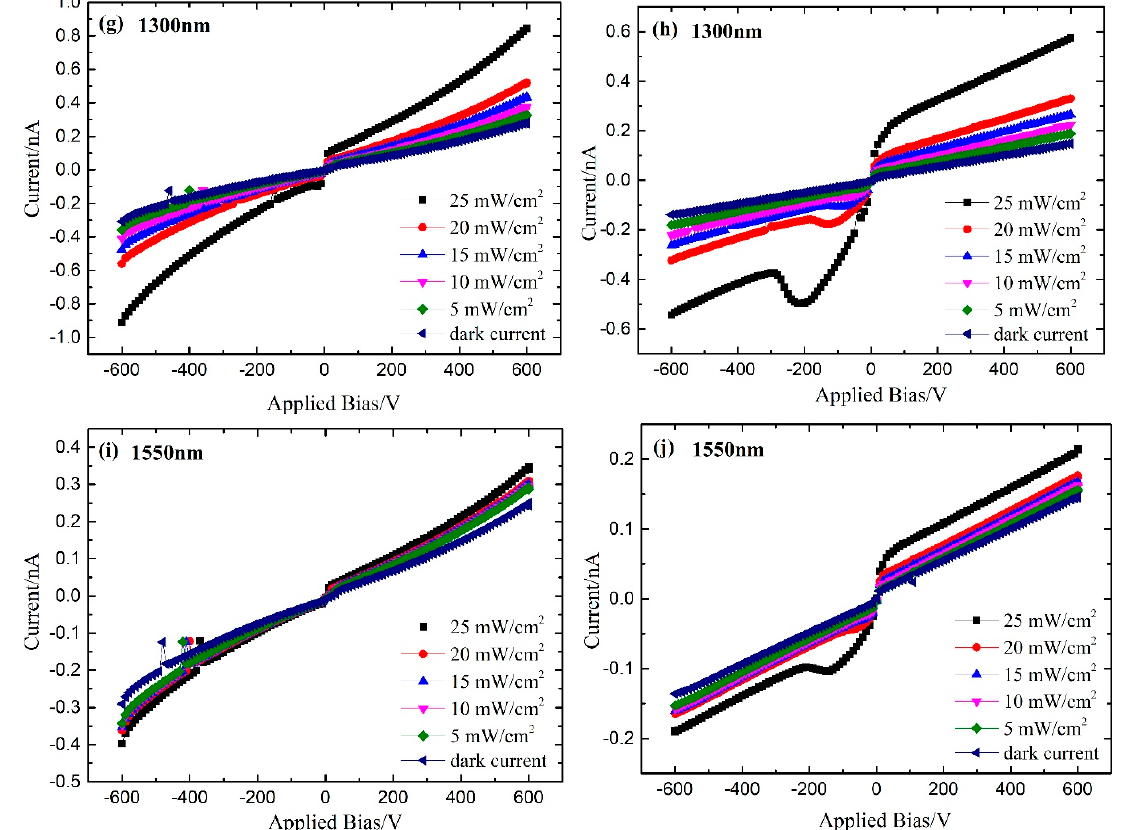
Figure 2. The current-voltage characteristics of CdZnTe detectors under radiation of the lights in the wavelength of 980 nm, 1050 nm, 1200 nm, 1300 nm, and 1550 nm without X-ray irradiation. ( a , c , e , g , i ) better counting performance detector; ( b , d , f , h , j ) poor counting performance detector.